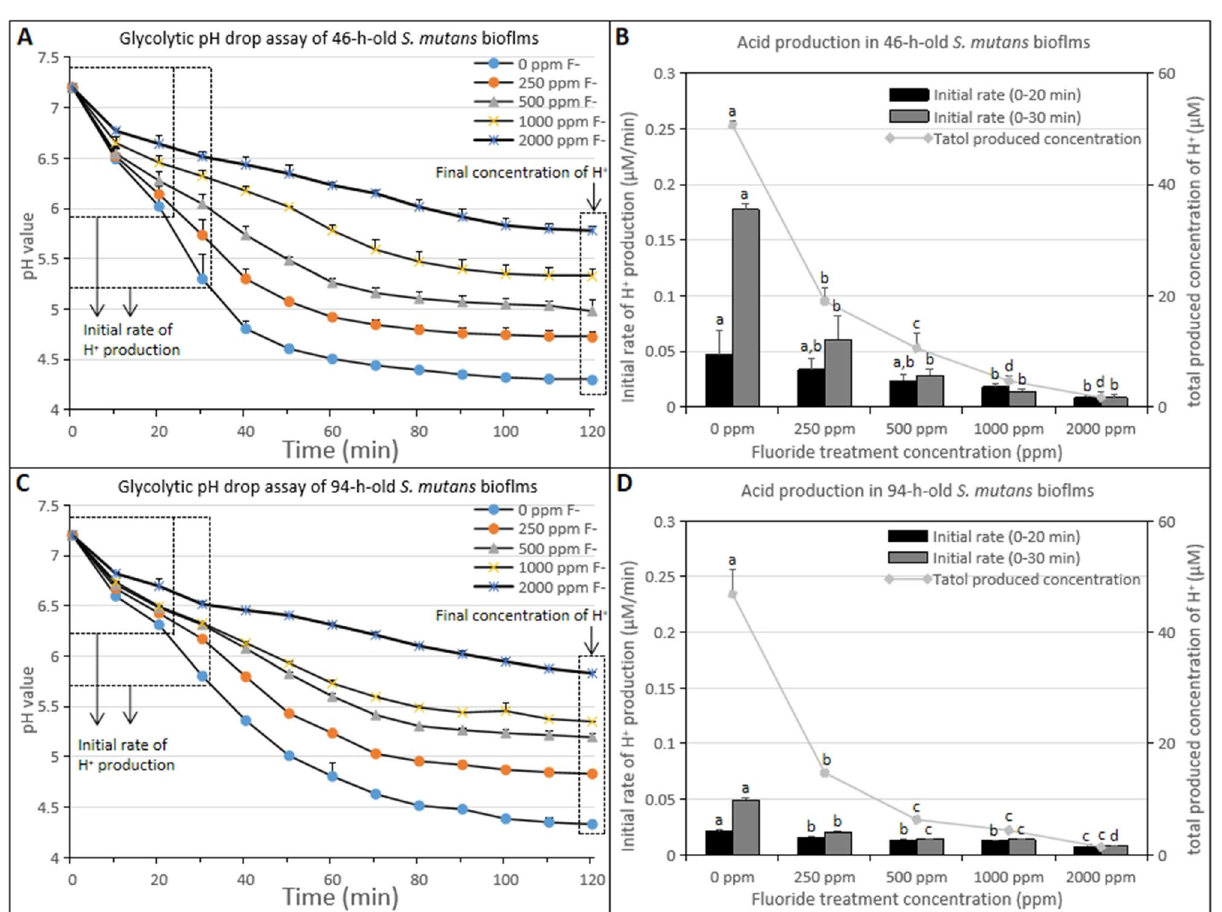
Figure 3. The effect of different concentrations of fluoride treatment on the acidogenicity of 46/94-h-old S. mutans biofilms cells. Changes in the initial rate of H + production (0–20 min; 0–30 min) and total produced concentration of H + (120 min) in 46/94-h-old S. mutans biofilms, calculated from biofilm glycolytic pH drop assay data. ( A ) Change in acid production of 46-h-old S. mutans biofilms ( p < 0.05). ( B ) Initial rate of H + production (0–20 min; 0–30 min) and total produced concentration of H + (120 min) in 46-h-old S. mutans biofilms ( p < 0.05). ( C ) Change in acid production of 94-h-old S. mutans biofilms. ( D ) Initial rate of H + production (0–20 min; 0–30 min) and total produced concentration of H + (120 min) in 94-h-old S. mutans biofilms ( p < 0.05). Data represent mean ± standard deviation. * p < 0.05: significantly different from each